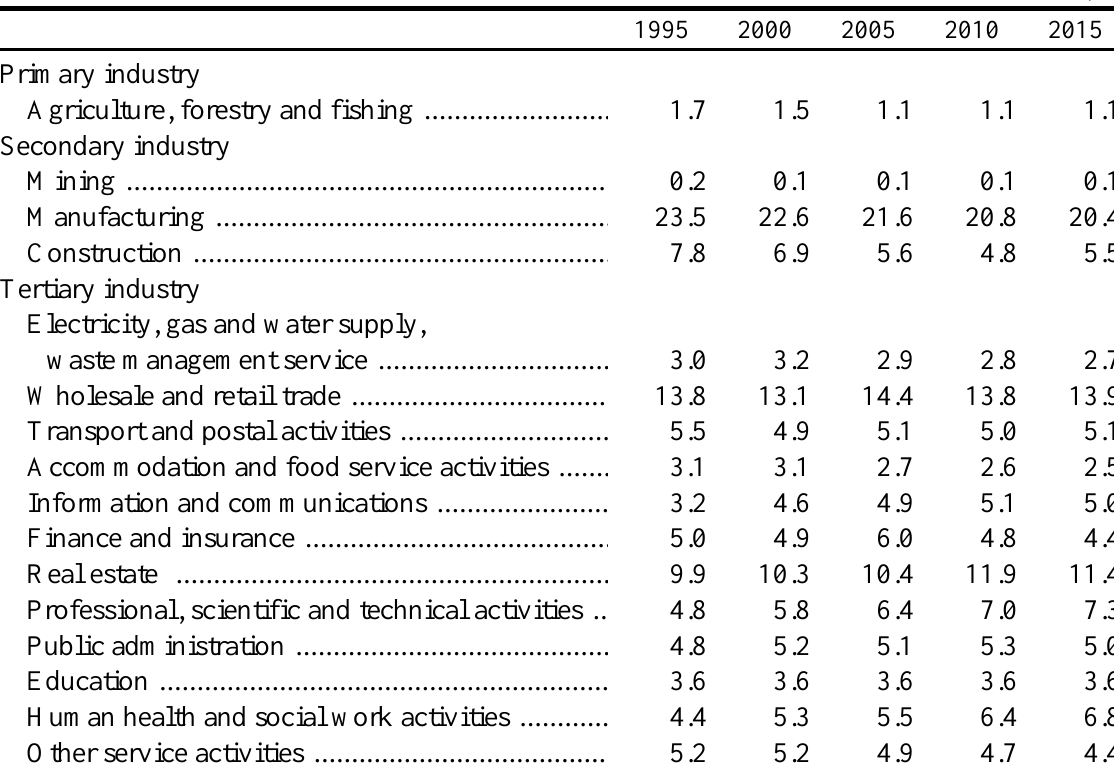
Gross Domestic Product by Type of Economic Activity